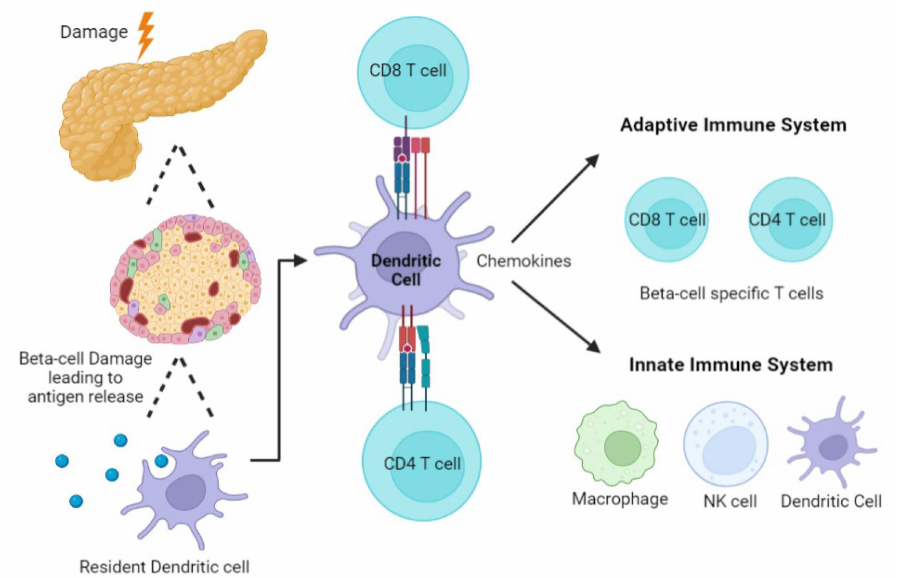
Figure 2. Major Immune Cells Implicated in T1D Pathogenesis. Damage to the β -cells of the pancreas can lead to the release of antigens. Antigens can be recognized by resident DCs which leads to the uptake and presentation of islet specific antigens to T cell. DCs will present antigens to T cells in the pancreatic lymph node leading to the release of chemokines which attract additional β -cell specific T cells and innate immune cells. If these β -cell autoantigen specific T cells are not removed by peripheral tolerance, they can further enhance inflammation and contribute to β -cell